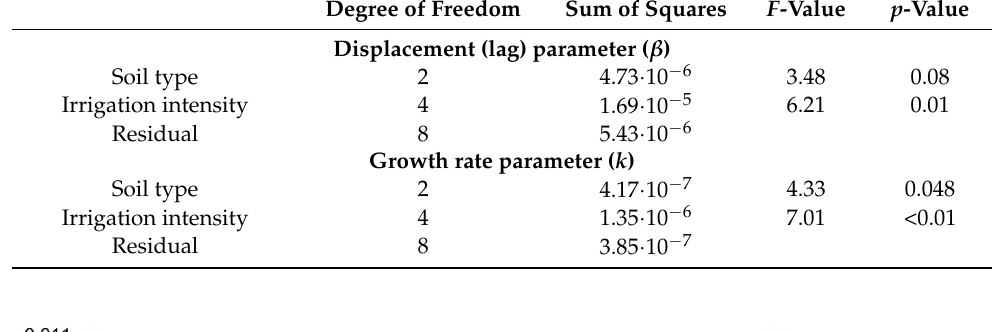
8 of 16 Table 3. The ANOVA (type II tests) table of the three parameters of logistic growth function (growth asymptote, displacement, and growth rate) of height growth cessation (after peak) of the studied third-year Norway spruce seedlings according to soil type and irrigation intensity. A sin- gle function was fit for each treatment. The interaction terms were not calculated due to limita- tions of the dataset.